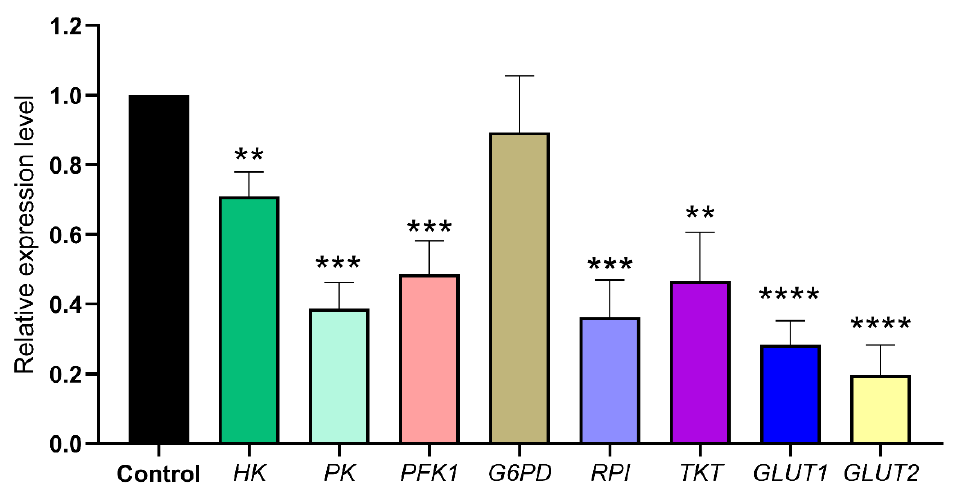
Figure 7. Relative expression levels of transcripts related to neoblasts energy metabolism detected by qRT-PCR. Asterisks indicate statistical differences (** p < 0.01, *** p < 0.001,**** p < 0.0001).